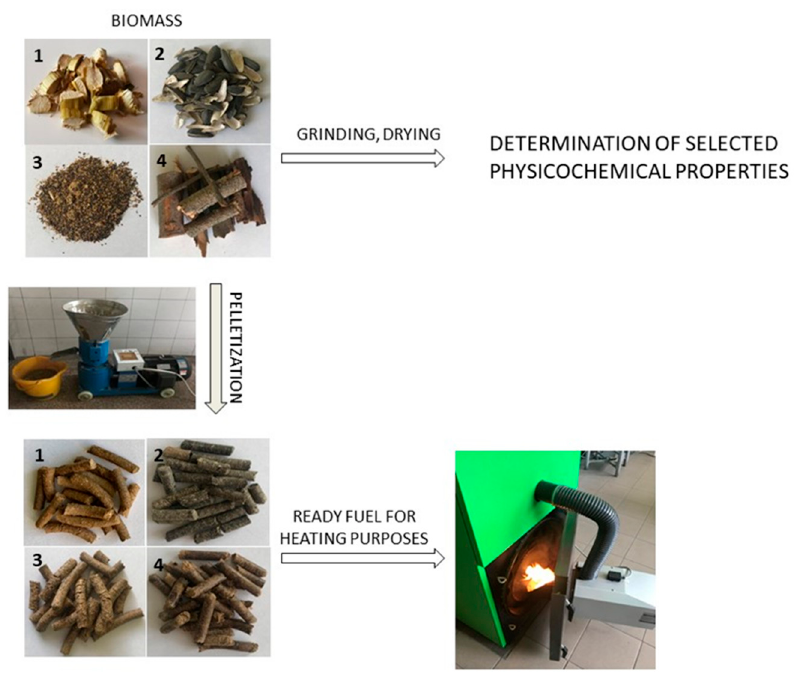
Figure 1. Scheme of the procedure of preparation and use of selected types of biomass as a heating fuel: 1—corn straw, 2—sunflower husk, 3—rapeseed cake, and 4—willow ( Salix viminalis ).